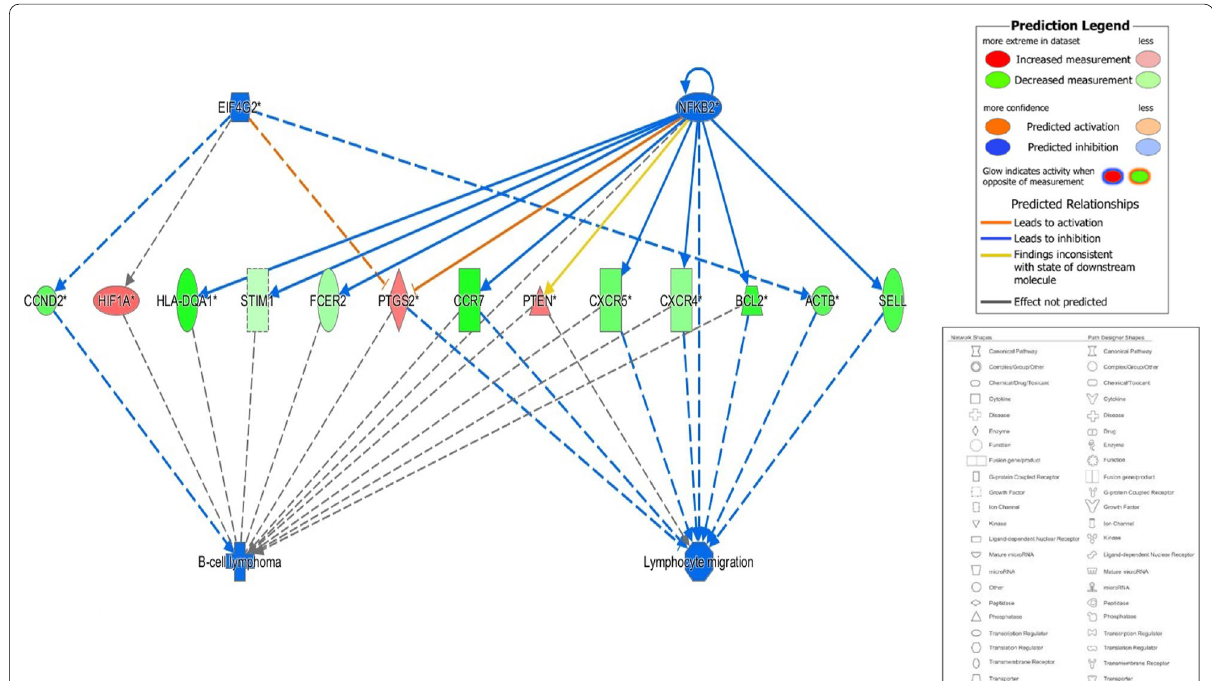
Fig. 4 Regulatory effect genes EIF4G2 and NFKB2 are predicted during sepsis. Different shapes represent the molecular class of the protein. Red and green indicate down-regulation and up-regulation, respectively, while blue and orange indicate inhibition and activation, respectively. A solid line indicates a direct interaction, a dashed line indicates an indirect interaction, and a dotted line indicates inferred correlation from machine-based learning. An asterisk indicates that multiple identifiers in the dataset file map to a single gene or chemical in the global molecular network